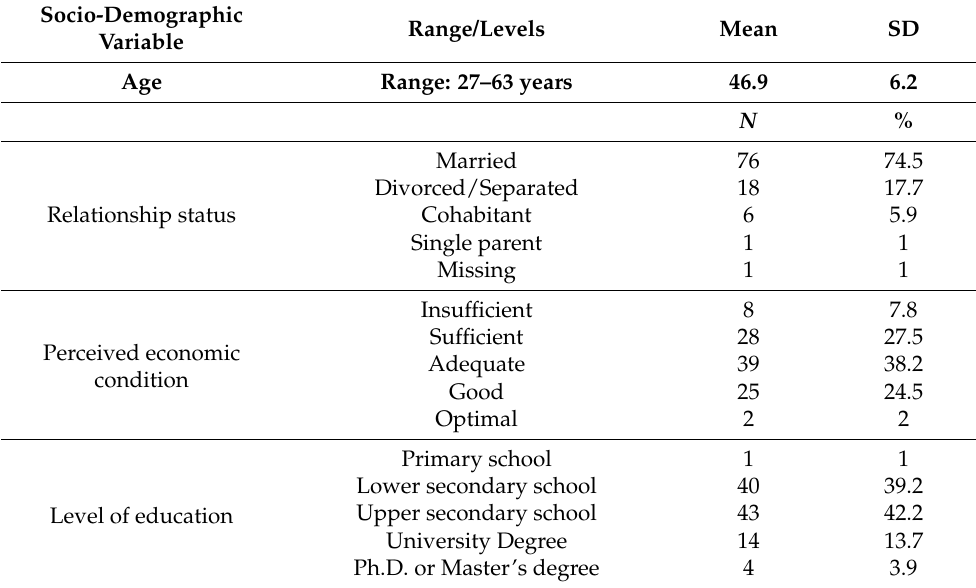
Table 2. Socio-demographic characteristics of